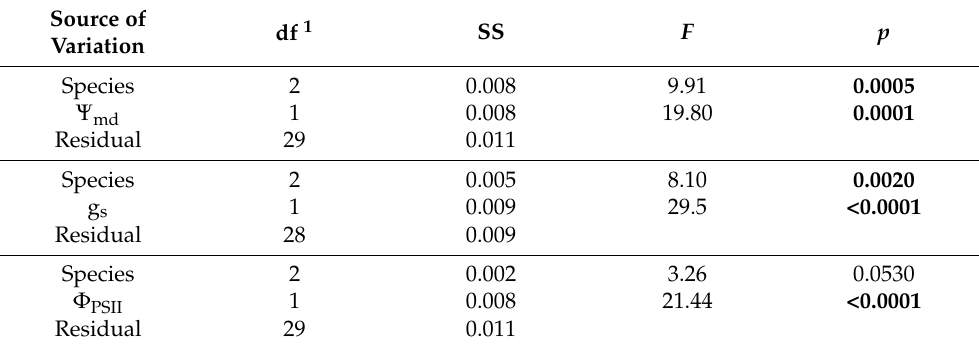
Table 1. ANCOVAs for testing differences in mass-based net photosynthesis (A mass ) among the three Oesporangium species. Three covariates were included in separate models: leaf water potential at mid-day ( Ψ md ), stomatal conductance (g s ), and quantum yield of the photosystem II ( Φ PSII ). The species × covariate interaction was not significant ( p > 0.05) in any of the models, so they were repeated without this interaction. Significant effects ( p < 0.05) are indicated in bold. Sample size ( n ) was 9, 10, and 14 individuals of HH , HHPP, and PP ,